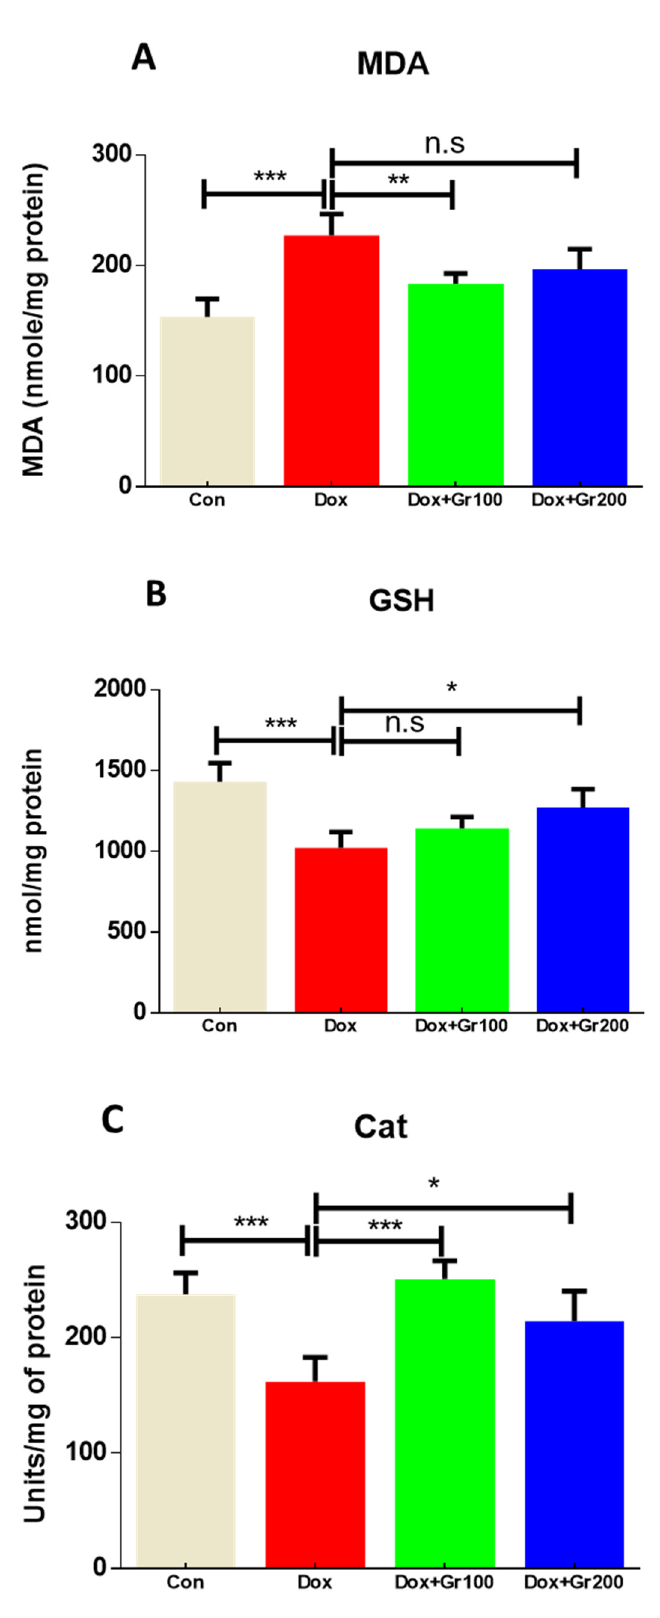
Figure 2. ( A – C ) Effects of geraniol (Gr), doxorubicin (Dox), or their combination (Dox + Gr100 and Dox + Gr200) on kidney oxidative stress indicators. Data are presented as mean + SD (n = 5). *, p < 0.05; **, p < 0.01; ***, p < 0.001; n.s., p > 0.05 or non-significant. Gr100 and Gr200 indicate 100 and 200 mg of geraniol per kilogram of body weight,